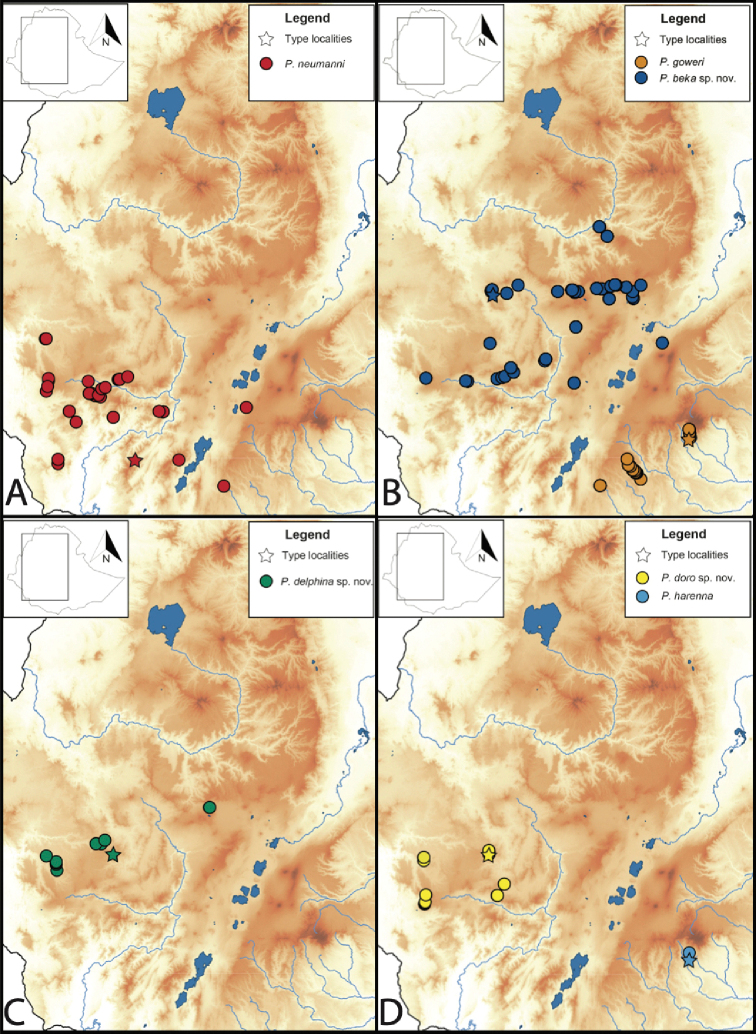
Distribution maps of members of the neumanni species group APtychadena
neumannisensu stricto (red circles) BPtychadena
beka sp. nov. (blue circles) and P.
goweri (orange circles) CPtychadena
delphina sp. nov. (green circles) DPtychadena
doro sp. nov. (yellow circles) and P.
harenna (light blue circles). Type localities for each species are indicated with a star.